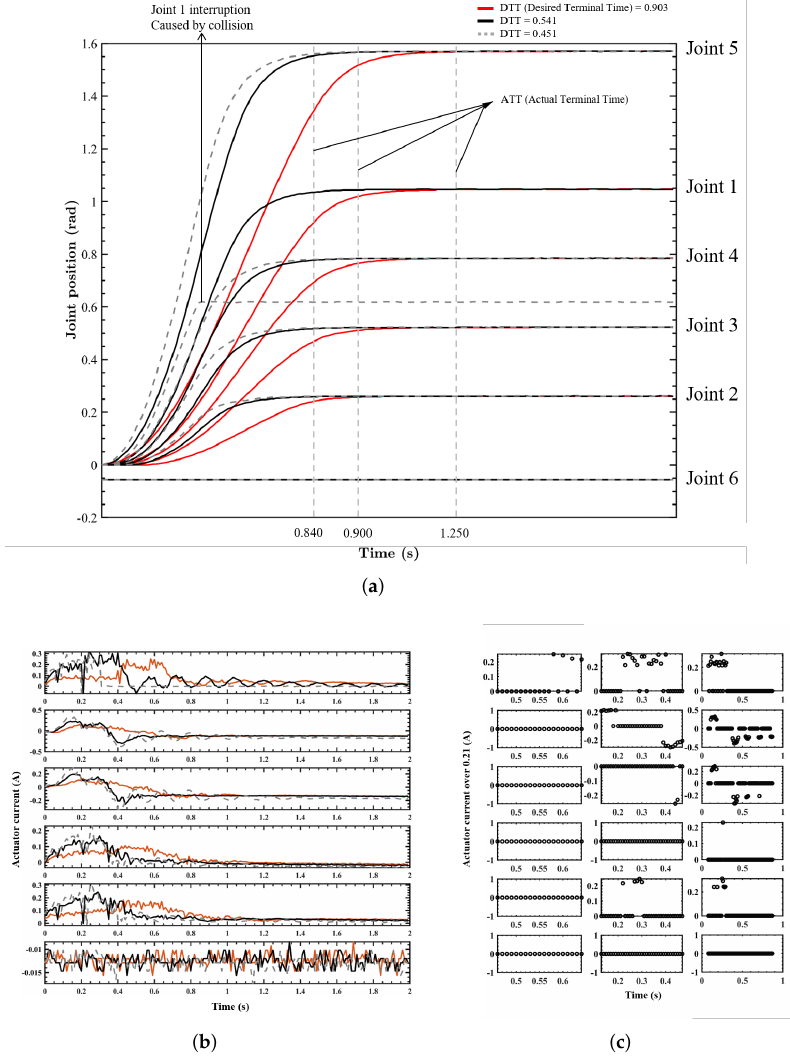
Figure 7. Experiment solutions of the OCP path with shorter DTT. In ( a , b ), the DDT of 0.903 s, 0.541 s and 0.451 s are refered to the red solid line, the black solid line and the gray dash line respectively. In ( c ), the DTT of the first column is 0.903 s, the DTT of the second column is 0.541 s, and the DTT of the third column is 0.451